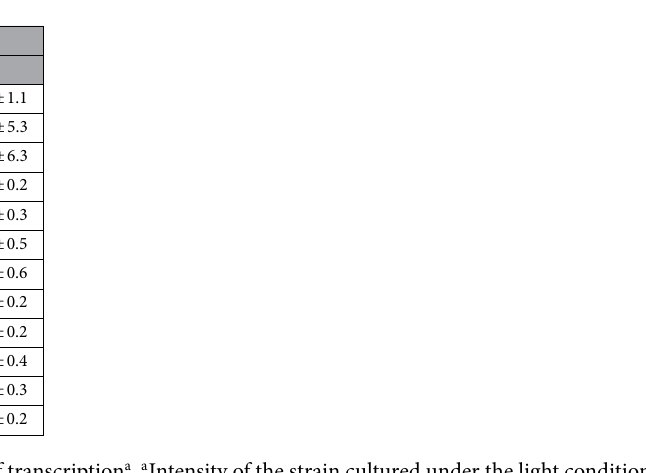
Table 1. Light-induced fold change of transcription a . a Intensity of the strain cultured under the light condition normalized to that of the strain cultured under the dark